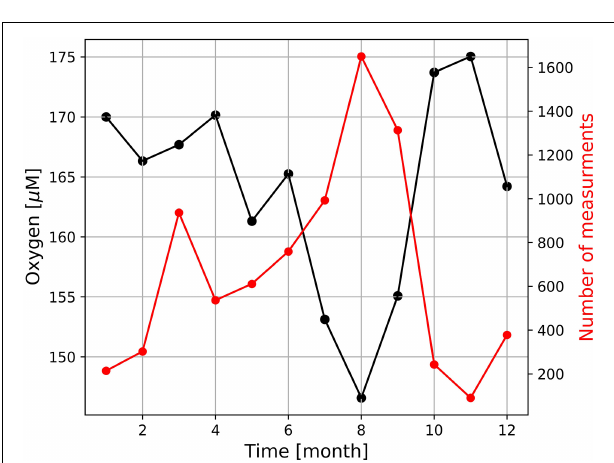
FIGURE 9 | Seasonal variation of dissolved oxygen measured by the deployed MDO sensor and the number of measures at which oxygen concentration were < 120 µ